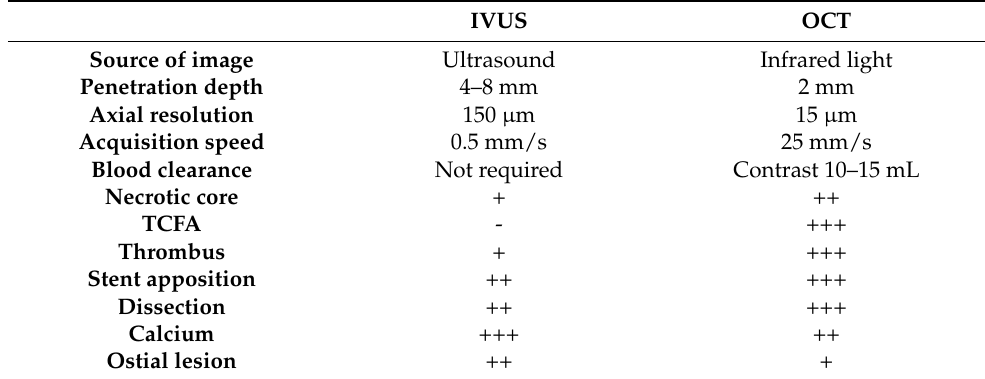
Table 1. Technical differences and diagnostic accuracy of OCT compared with IVUS. IVUS OCT Source of image